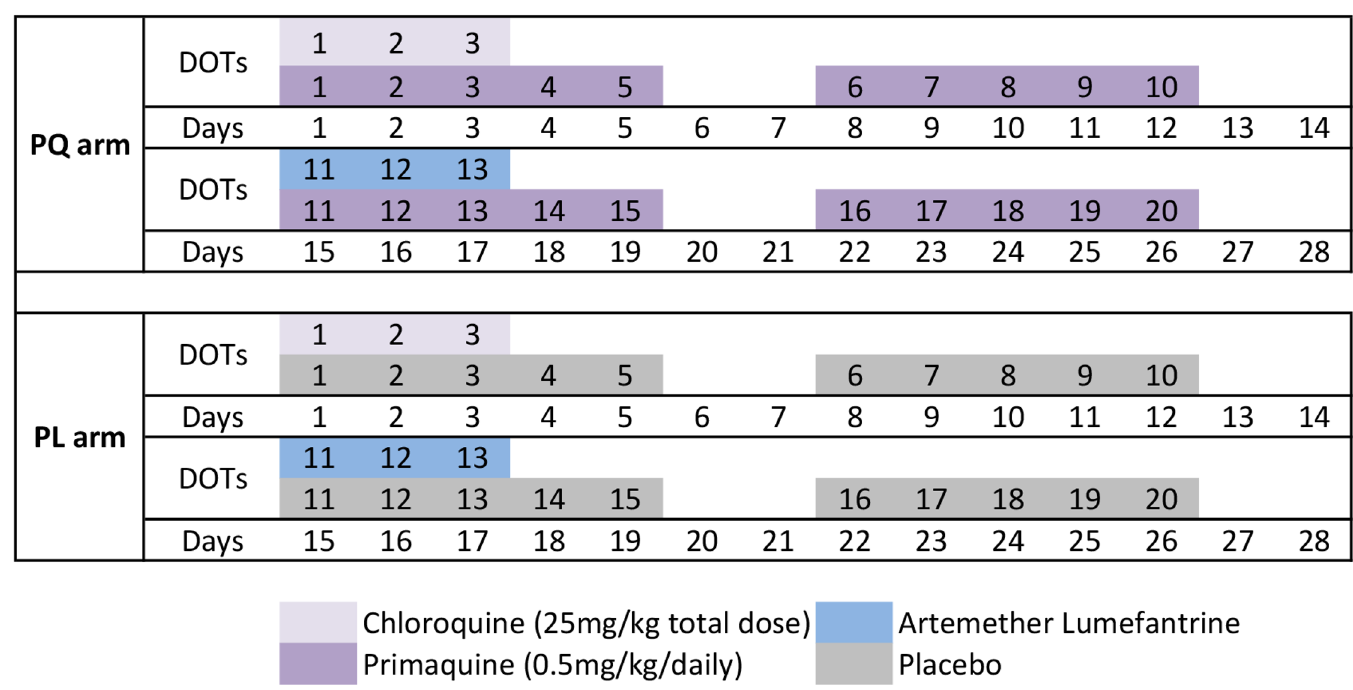
Fig 1. Drug administration schedule. The drug regimen for the PQ and PL treatment arms was administered with direct observation on 20 d (Monday to Friday) over a 4-wk (26-d)